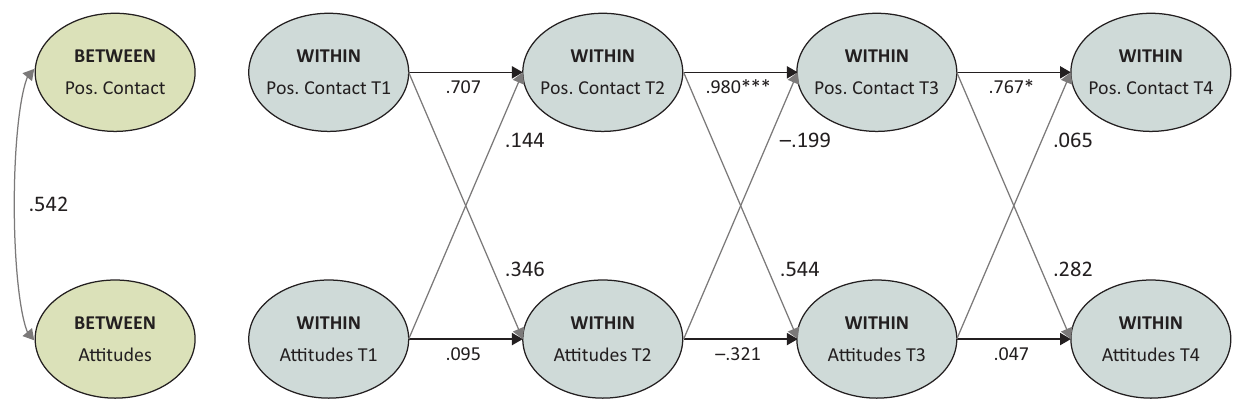
Figure 2. RI-CLPM for foreigners. Notes: Standardized regression coefficients are reported. The model is simplified and depicts only the structural relations of interest, omitting the underlying measurement model and covariations between constructs at the same timepoint. Green ellipses describe stable between-person differences, while blue-grey ellipses de- scribe situational within-person processes. Significant paths are depicted darker. * p < .05; *** p <